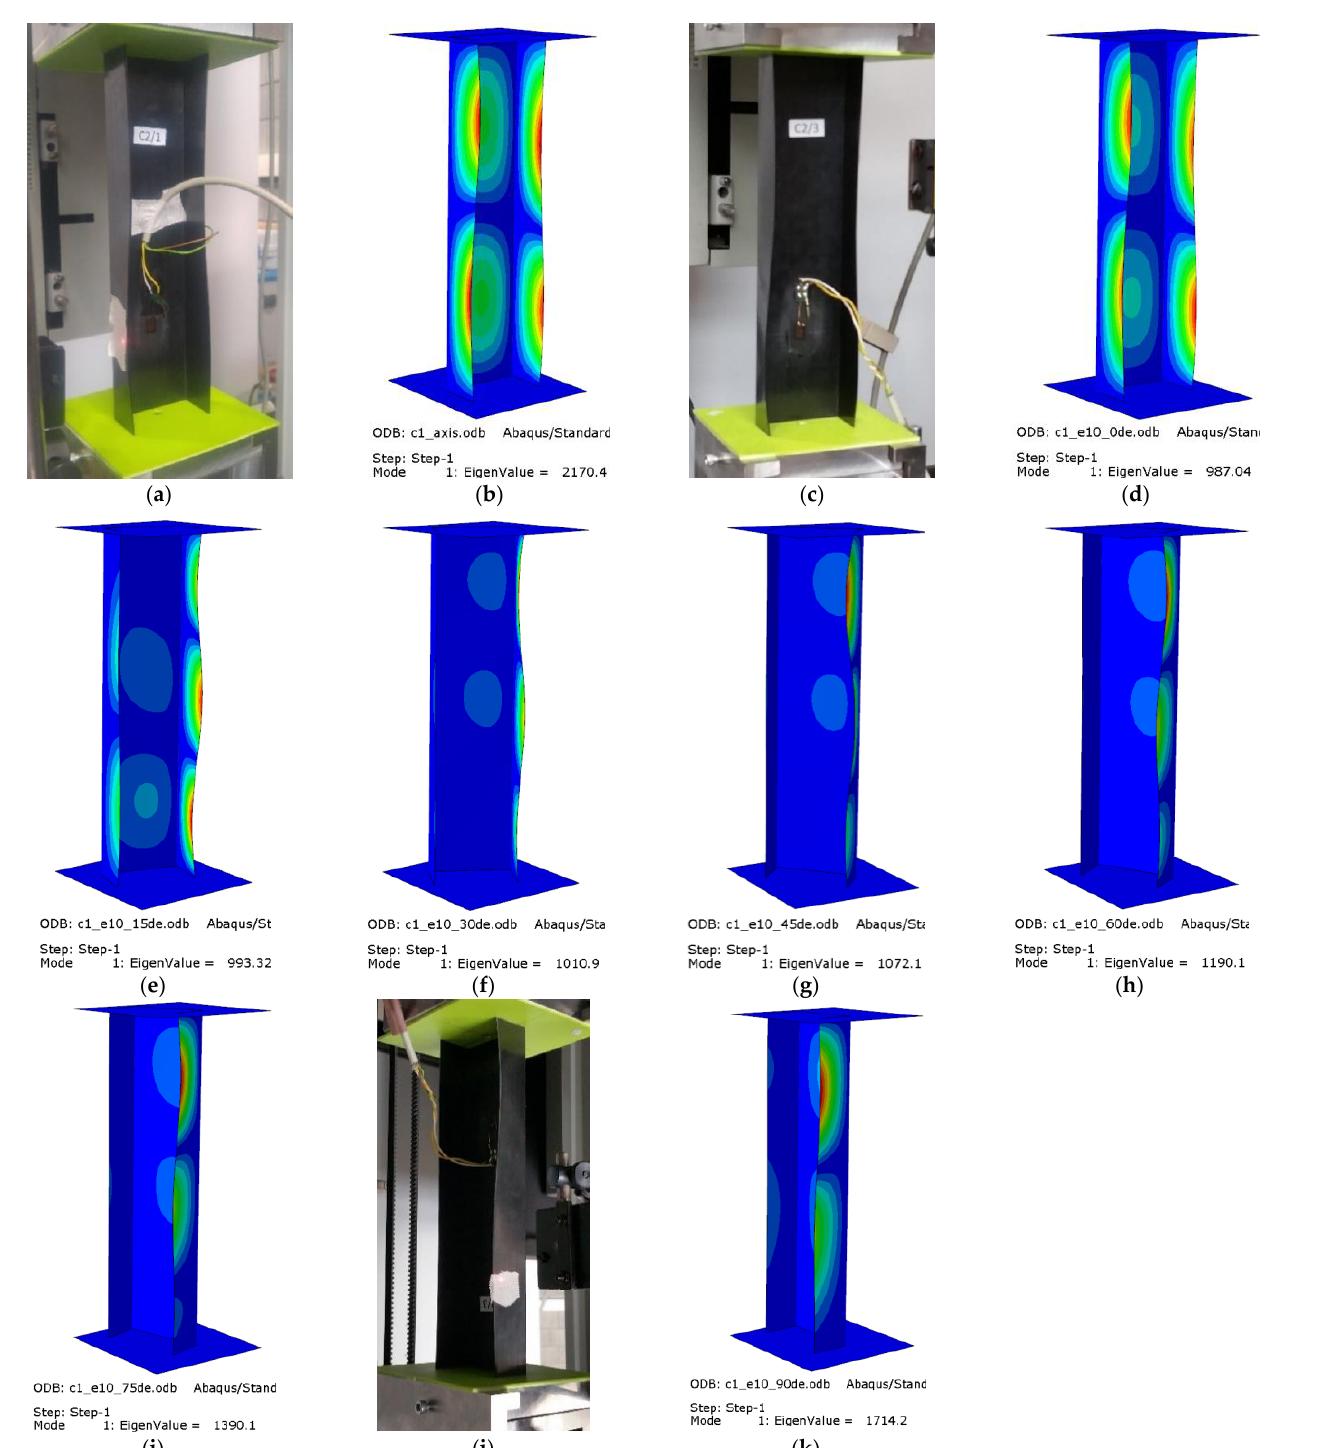
Figure 8. Buckling modes for C1 [0/45/ − 45/90] s : ( a ) axis EXP, ( b ) axis FEM, ( c ) e10_0° EXP, ( d ) e10_0° FEM, ( e ) e10_15° FEM, ( f ) e10_30° FEM, ( g ) e10_45° FEM, ( h ) e10_60° FEM, ( i ) e10_75